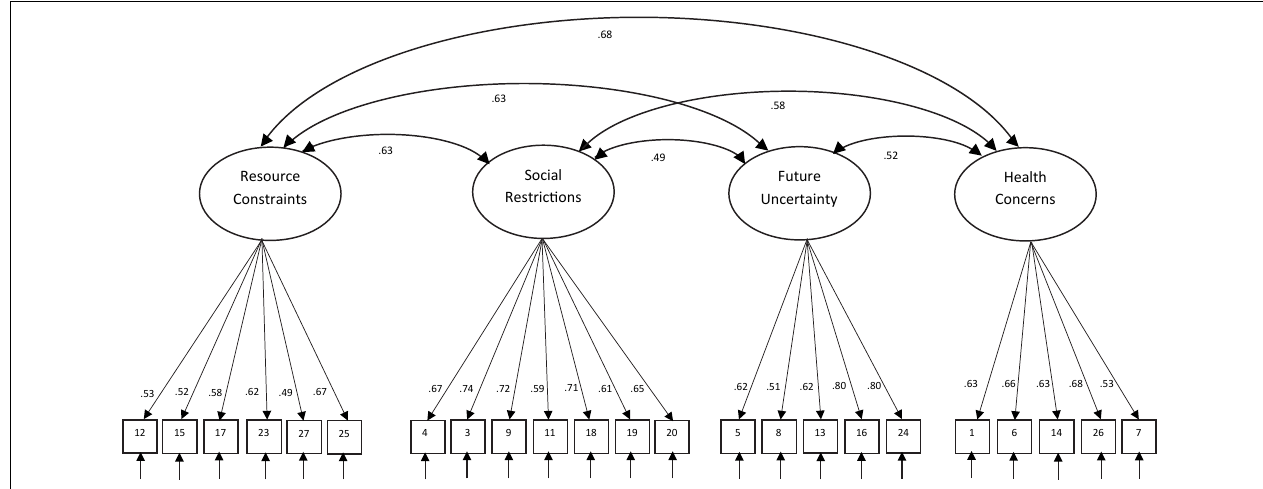
FIGURE 2 | Standardized factor loadings and latent factor correlations for the final 23-item four-factor CFA model. TABLE 3 | Correlation matrix of measured variables. Females n =